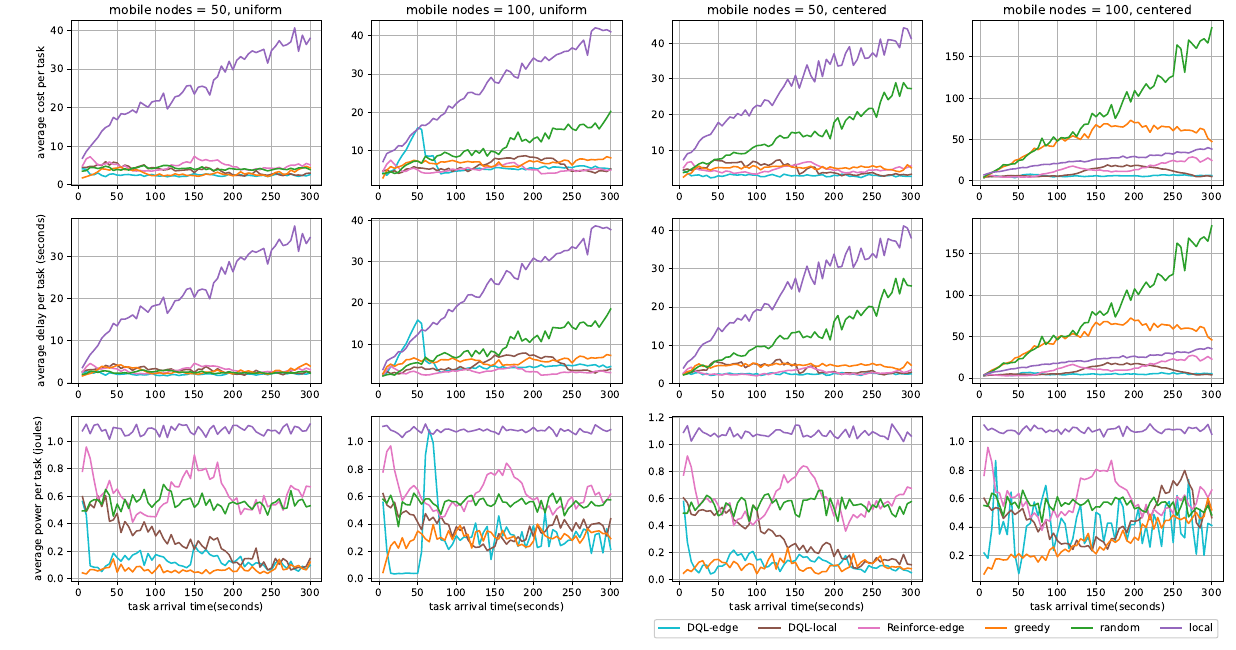
Figure 2. Comparing the cost, delay, and power consumption of the DQL-edge, DQL-local, reinforce- edge, greedy, random, and local task-offloading models for the duration of the simulation. The simulation was run for both centered and uniform positioning of mobile devices and when the number of mobile devices was 50 and